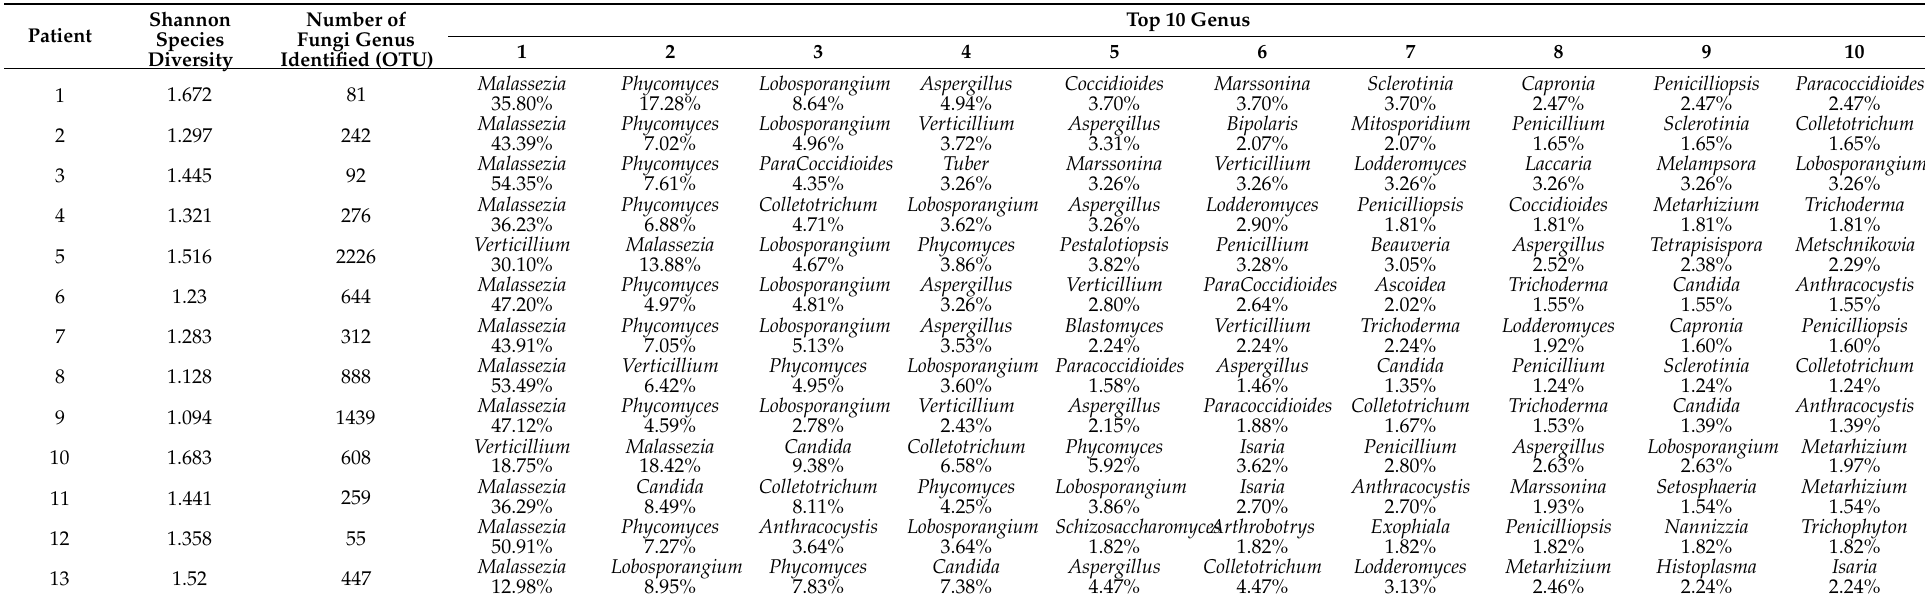
Table 3. Fungi identified in the nasal irrigation of chronic rhinosinusitis based on nanopore